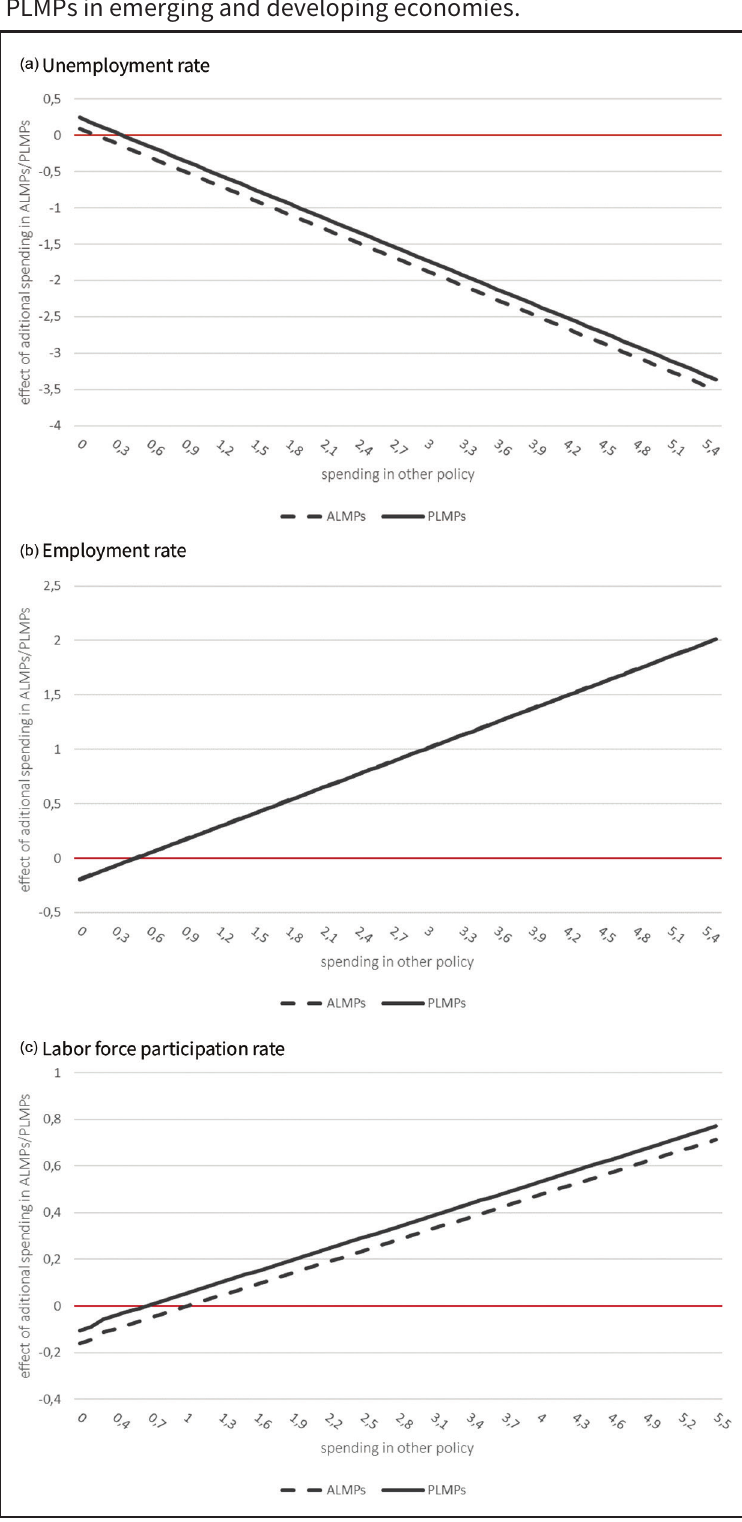
Figure 5. The effect of one additional unit spending on ALMPs (PLMPs) given spending on PLMPs in emerging and developing